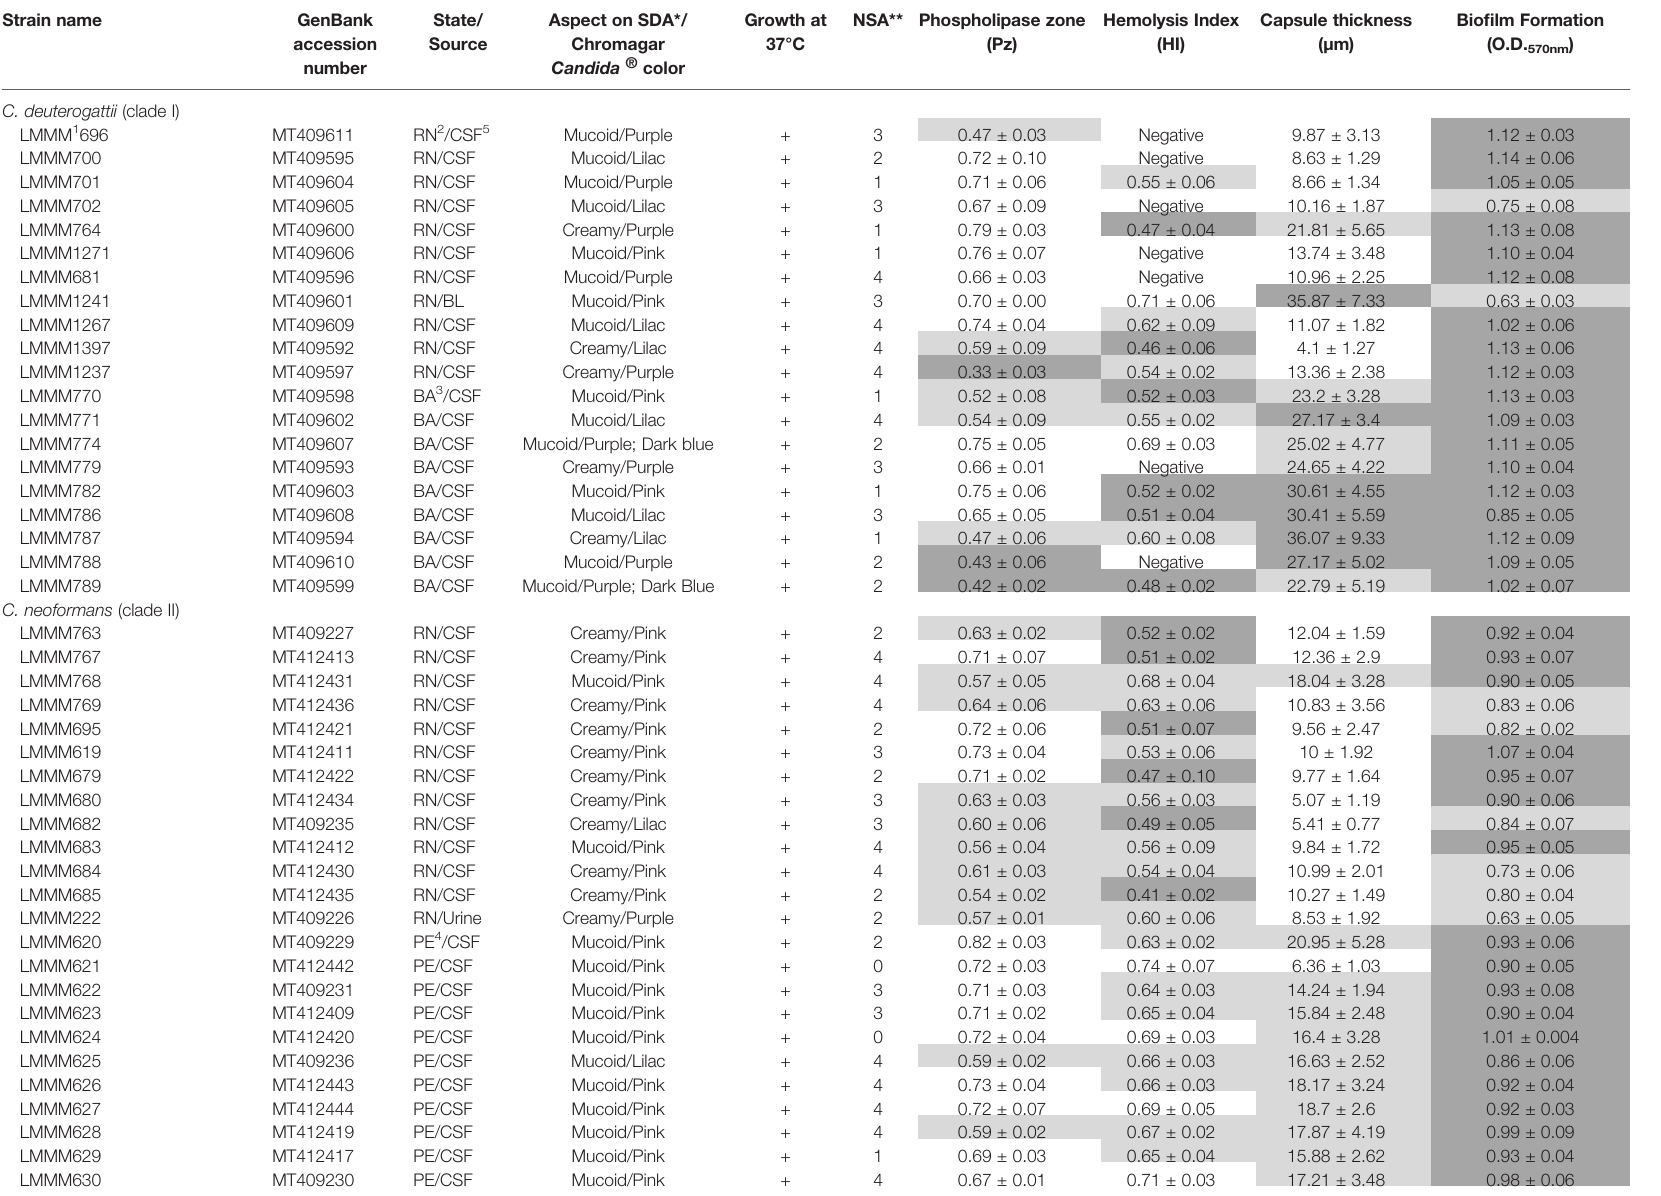
TABLE 1 | Phenotypic properties and virulence attributes determined in vitro of clinical and environmental isolates of Cryptococcus spp. and related genera obtained from patients and PD in Northeast Brazil. Strain